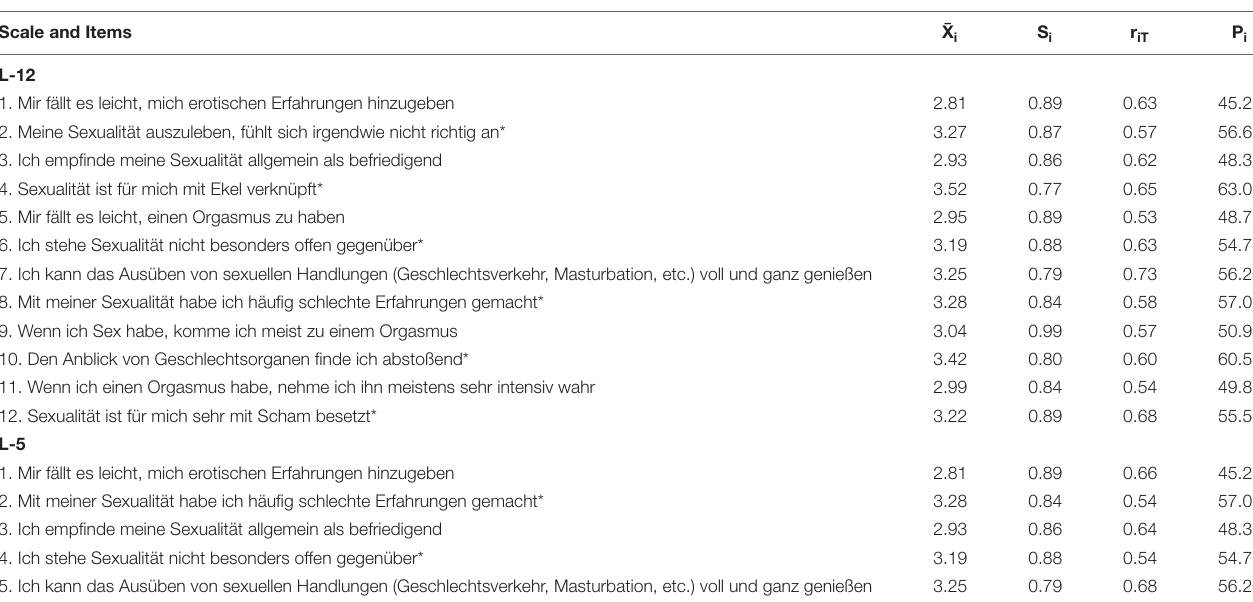
TABLE 2 | Item-characteristics of L-12 and L-5